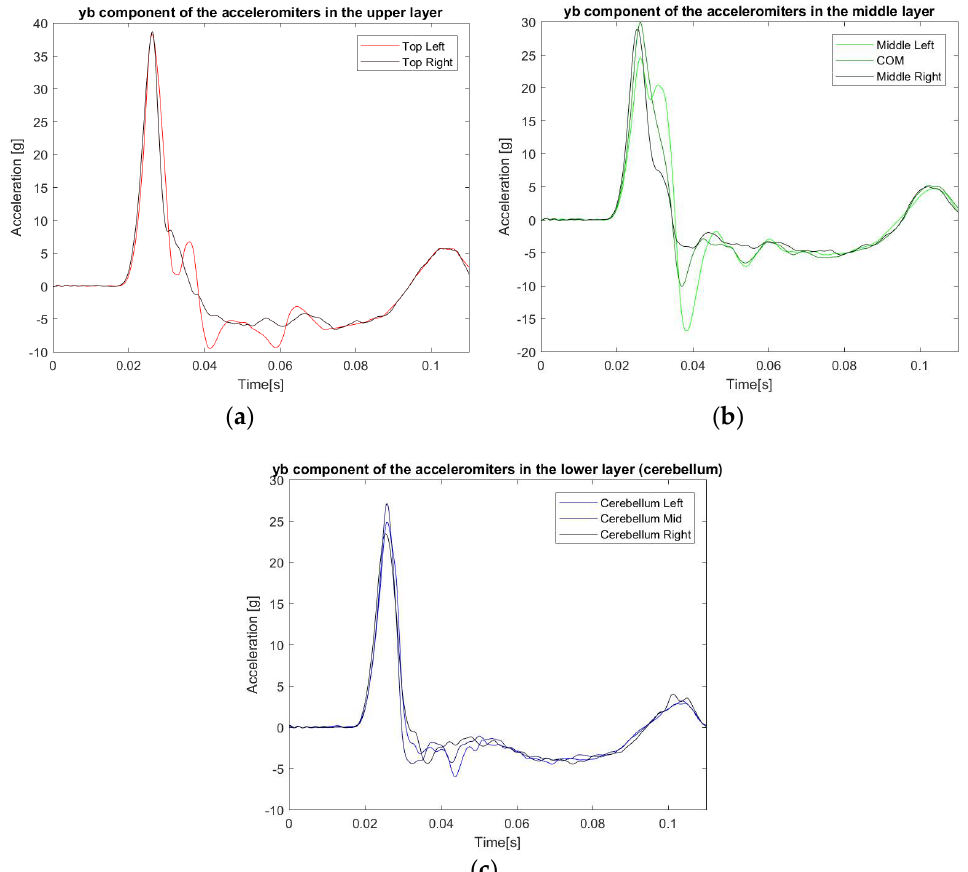
Figure 5. Results of a right side impact at 16 J on surrogate IHHeadS_1 in lateral yb direction. ( a ) Top brain accelerometers; ( b ) middle brain accelerometers; ( c ) cerebellum